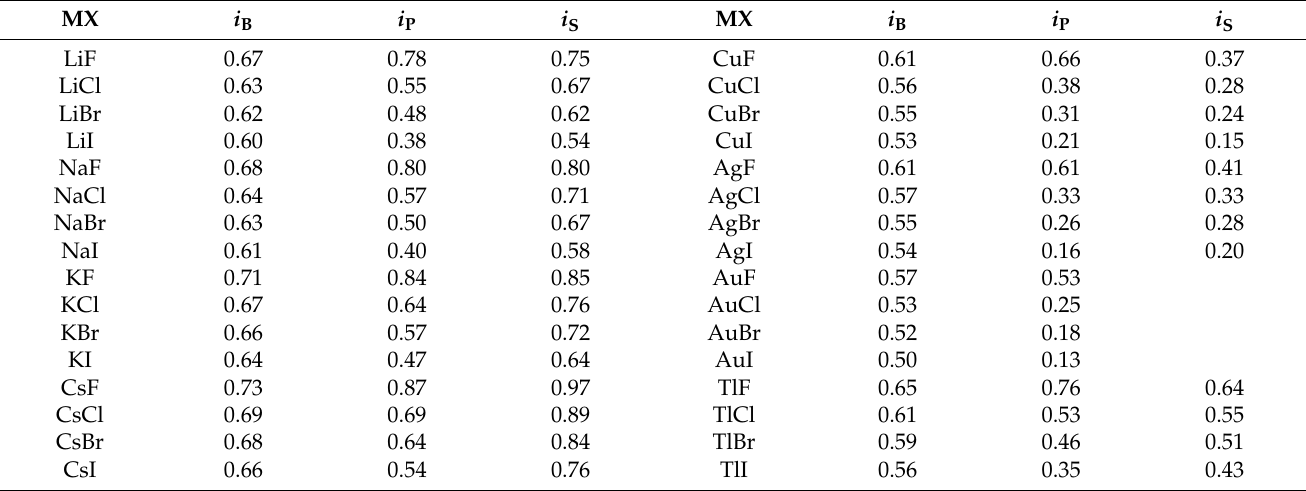
Table 9. Bond ionicity in MX